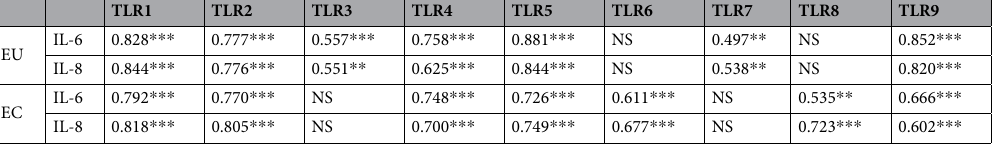
Table 2. Correlations between the mRNAs expression of IL-6 and IL-8 and TLRs in EU and EC. Note: EU: eutopic endometrium with adenomyosis; EC: ectopic endometrium with adenomyosis. NS P > 0.05; * P < 0.05; ** P < 0.01; *** P <